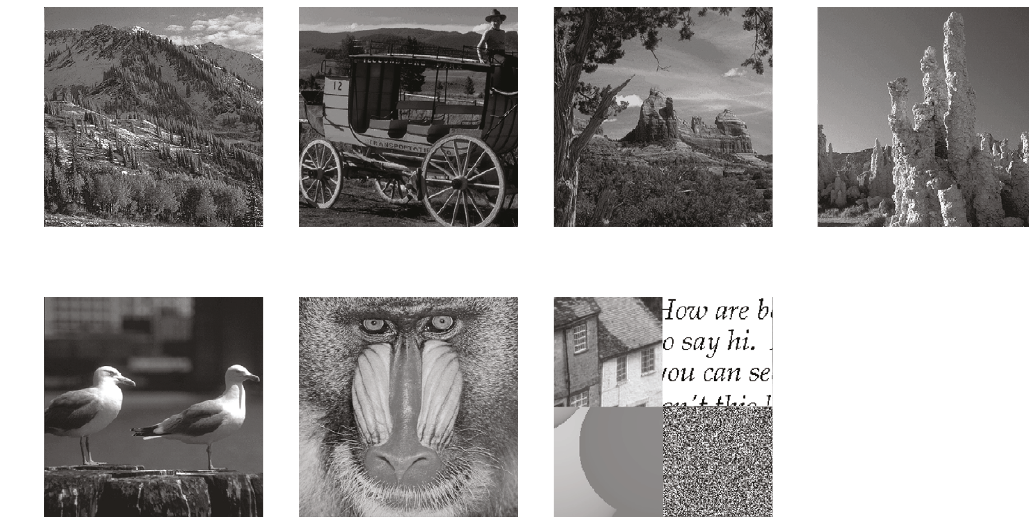
Figure 8: Image files in the training data set (Fold 2).